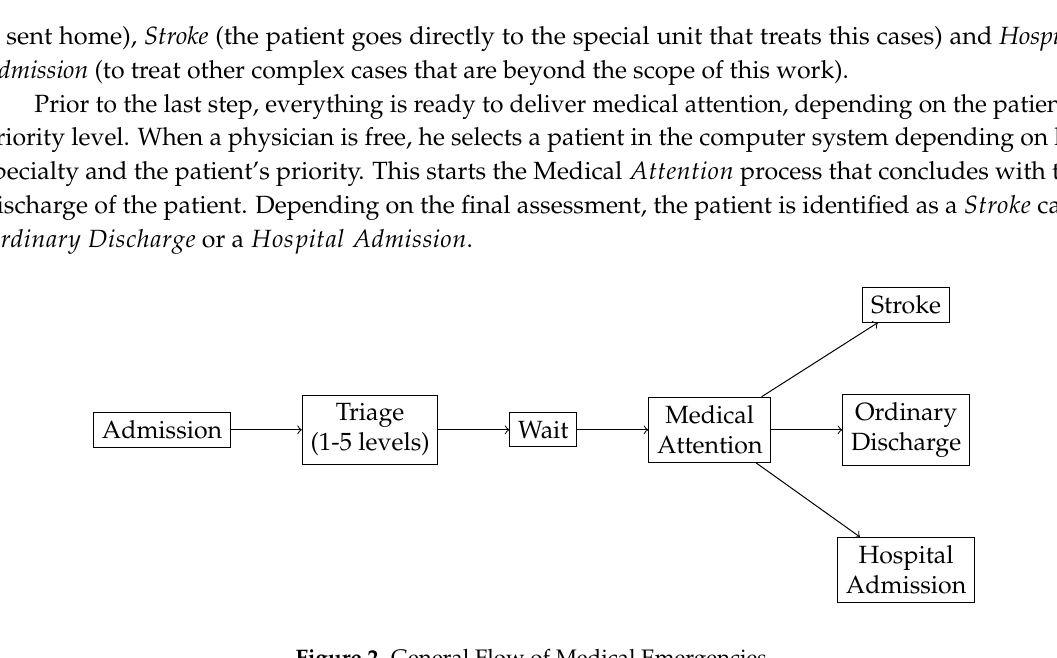
Figure 2. General Flow of Medical